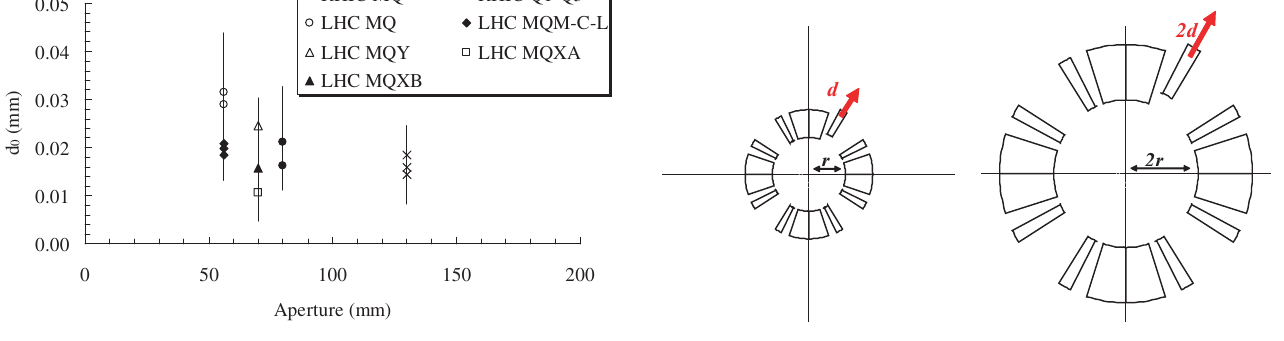
FIG. 2. Coil positioning versus aperture derived from magnetic measurements of 7 types of superconducting quadrupoles.